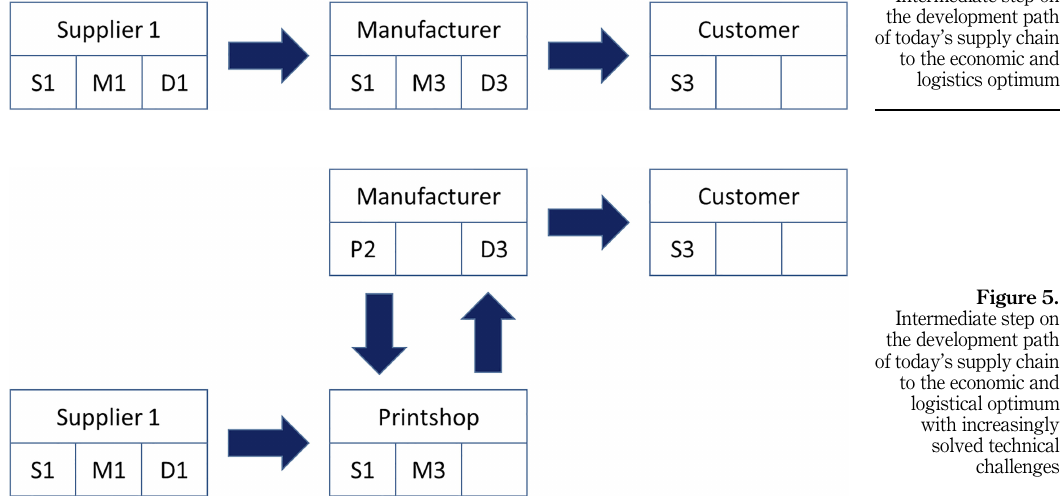
Figure 4. Intermediate step on